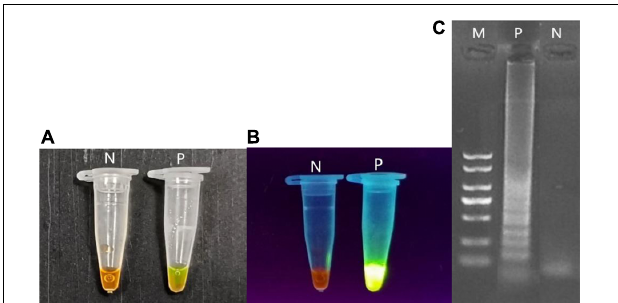
FIGURE 1 | Interpretation of LAMP amplification results.LAMP amplification results: P: Positive control, N: Negative control. (A) Under natural light, after adding SYBR green I P: yellow-green, N: Dark yellow. (B) Under UV light, after adding SYBR green I, P: bright green, N: Dark orange. (C) After being electrophoresed on a 2% agarose gel, P: Stepped band, N: None.